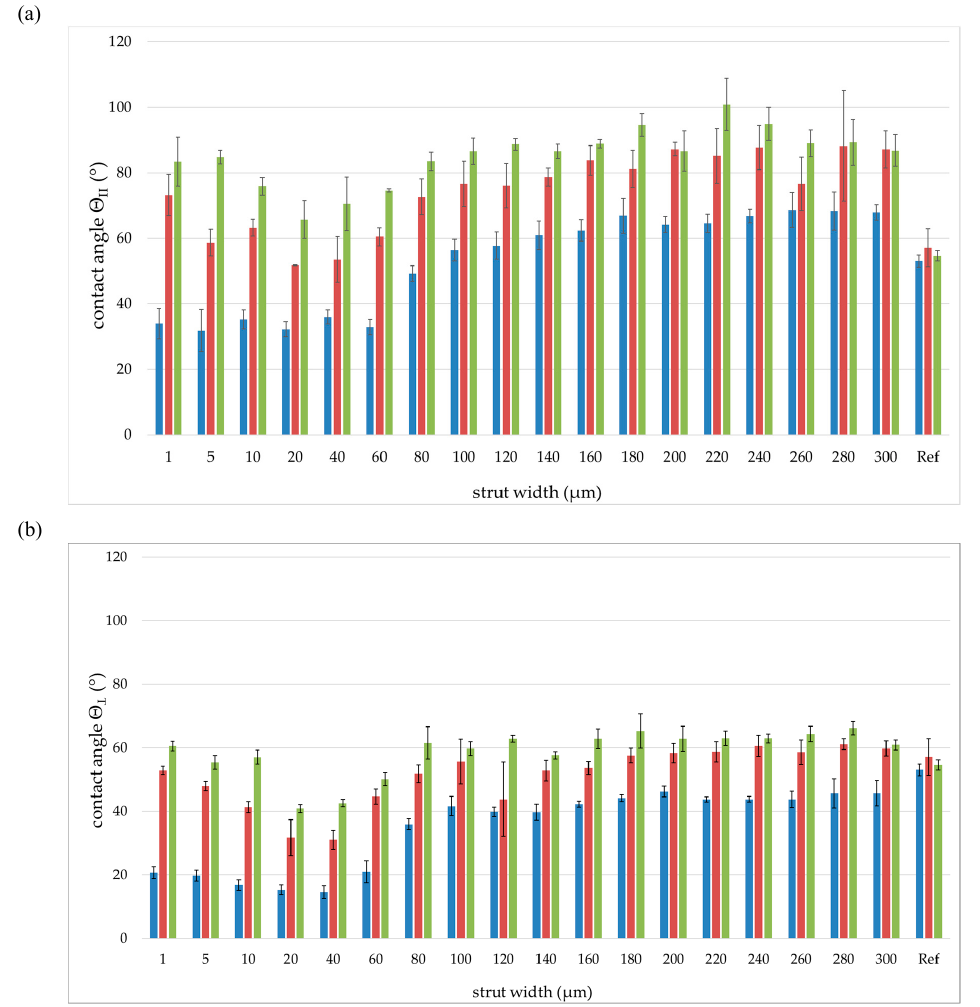
Figure 3. Contact angle over time (blue: 1 day, red: 8 days, and green: 15 days after laser treatment) and strut width. ( a ) Contact angles Θ ‖ parallel and ( b ) contact angles Θ Ʇ perpendicular to the groove direction.